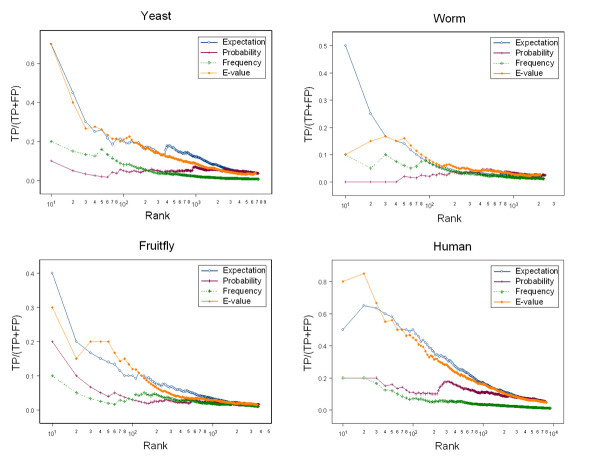
The relationship between rank and true positive rate (TP/(TP+FP)) compared to the iPfam for four species based on four score functions. "Expectation" ranks domain pairs according to the expected number of occurrences of domain pairs in protein interactions; "Probability" ranks domain pairs according to the estimated probability of interactions from the MLE method; "Frequency" ranks domain pairs according to the number of protein interactions having domain pair; "E-value" ranks domain pairs according to the E-value defined in [1].